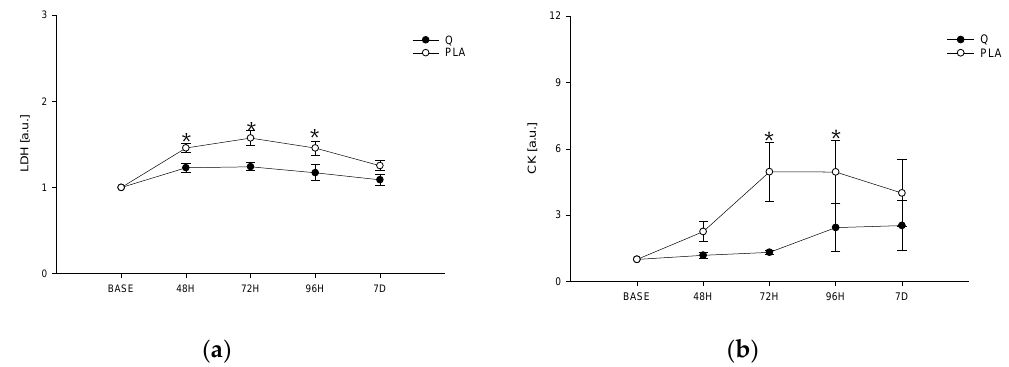
Figure 4. Lactate-dehydrogenase (LDH) ( a ) and creatine kinase (CK) ( b ) in Q and PLA before, after the EEIMD and during the recovery. Mean ± SD; * ≠ from Q p < 0.05.